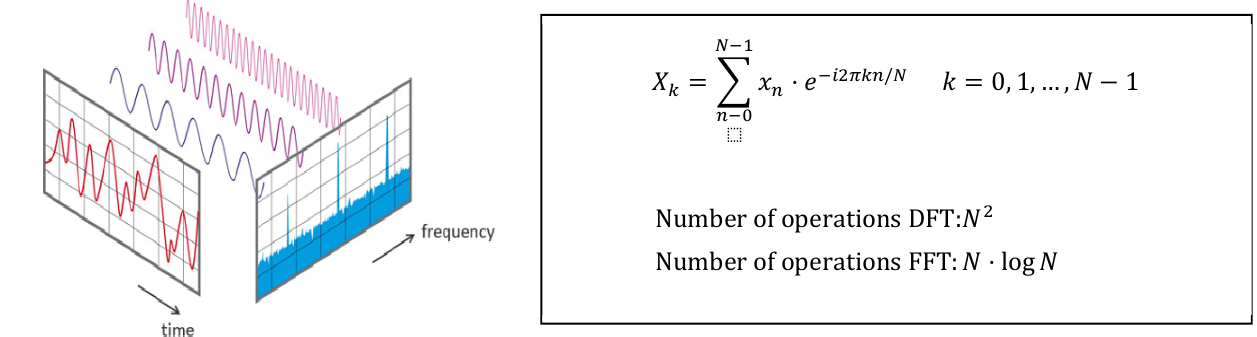
Figure 5. Graphical representation of the Fourier transform, equation and number of operations [25].